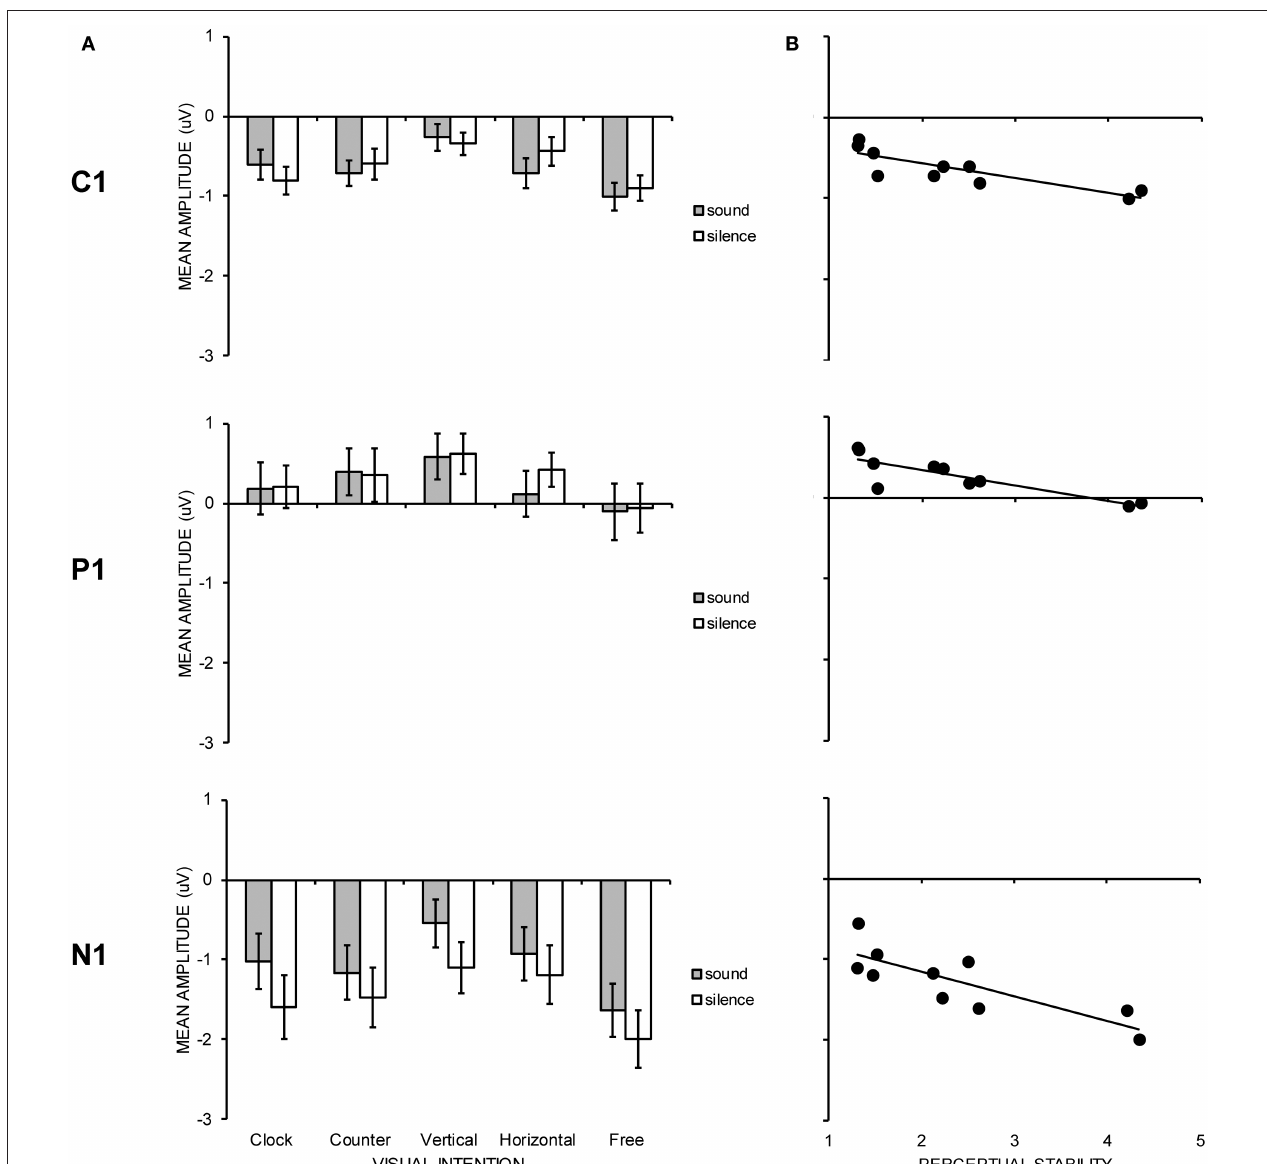
Figure 4 | (A) Graph showing group mean amplitudes for C1, P1, and N1 visual ERP components as a function of experimental condition. Error bars denote SE. (B) Scatterplot showing group average correlation between C1, P1, and N1 mean amplitude and the degree of perceptual stability judged on a 7-point scale (1 = extremely stable, 7 =